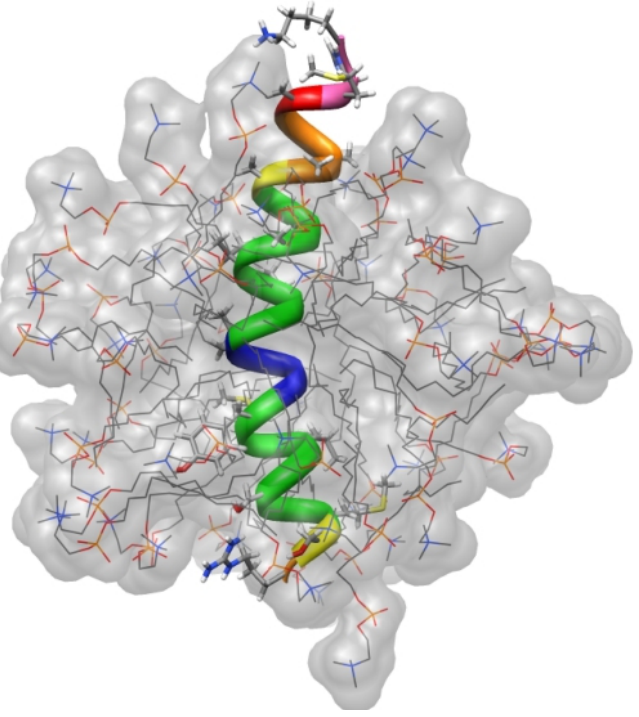
Gd(DTPA-BMA) are color-coded from low (blue) to high (red-pink). Reproduced with permission from